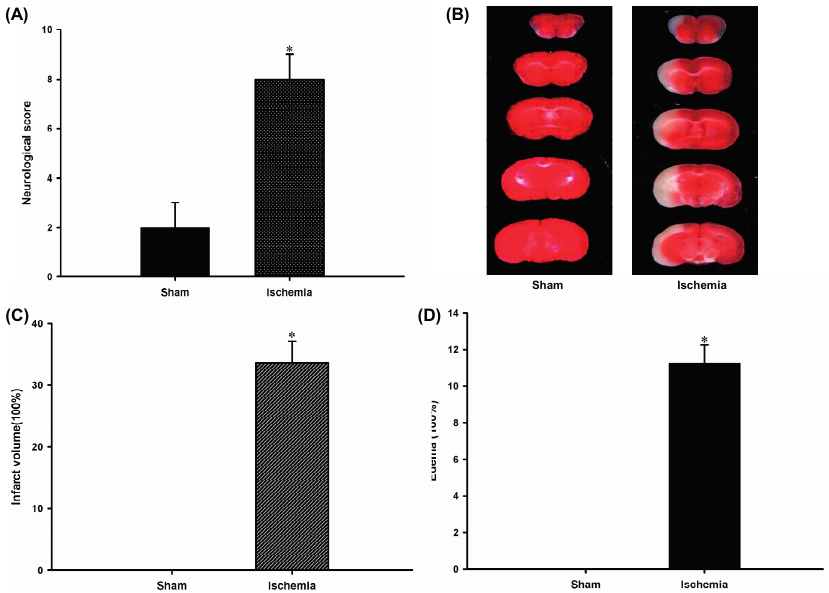
Figure 1. MCAO induced mice cerebral injuries. ( A ) Statistical results of neurological score from the Sham and Ischemia groups ( n = 6 per group). * p < 0.05; ( B ) Representative photographs of TTC-stained coronal brain sections of mice from the Sham and Ischemia group; ( C ) Statistical results of infarct volume from the sham and Ischemia groups ( n = 6 per group). * p < 0.05; and ( D ) Statistical results of edema ratio from the Sham and Ischemia groups ( n = 6 per group). * p <